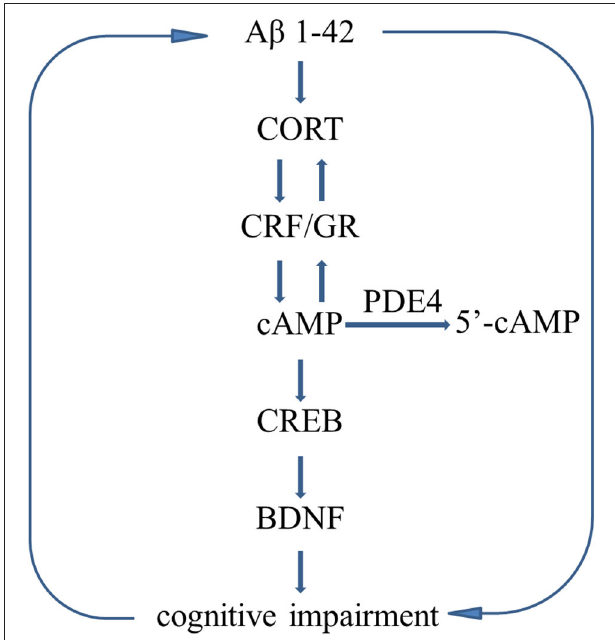
FIGURE 8 | Molecular mechanisms describe the A β -induced vicious circle. A β 1-42 induces HPA axis hyperactivity and decreases the cAMP level, leading to abnormalities in downstream molecules, i.e., decreased phosphorylation of CREB and BDNF expression, which in turn to deteriorate learning and memory disorders. However, Inhibition of PDE4 increases cAMP level and stimulates HPA axis negative feedback regulation, resulting in decreases in CORT releasing and CRF receptor and GR